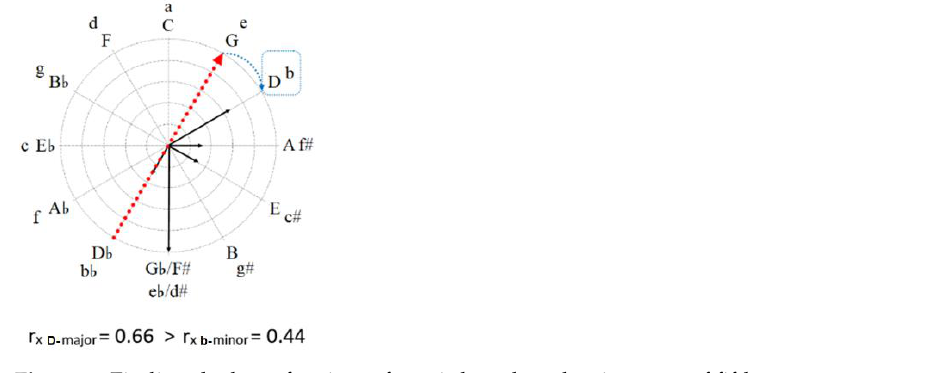
Figure 5. Finding the key of a piece of music based on the signature of fifths.